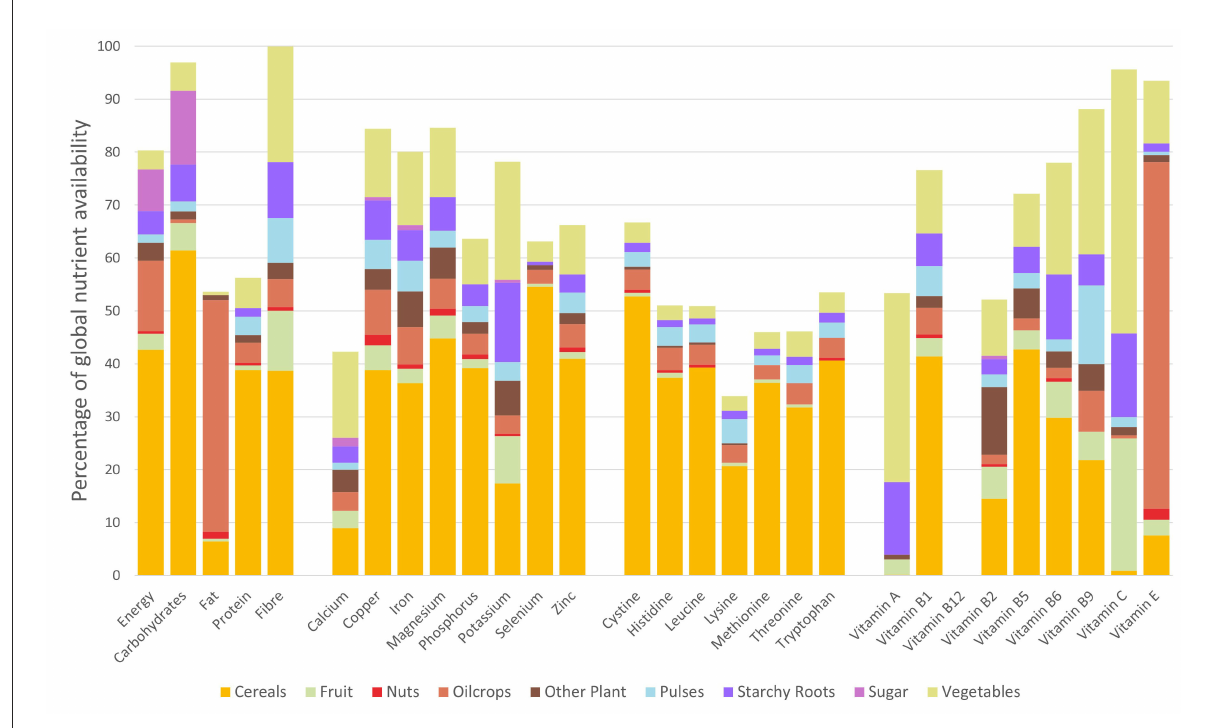
FIGURE3 Contribution of plant foods to global nutrient availability. These values were calculated using the DELTA Model ® (version 1.3; Sustainable Nutrition Initiative ® , 2021), so have been adjusted for waste, inedible portions, and bioavailability as described in section